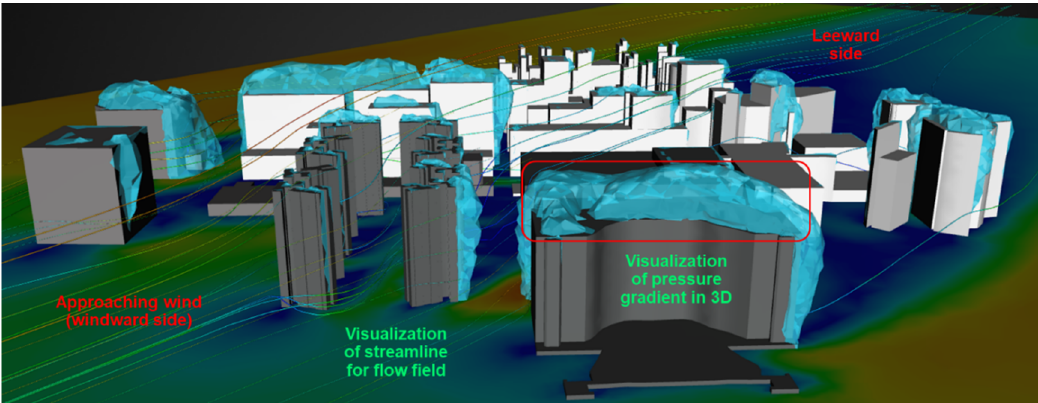
Figure 16. VR visualization for CFD results.